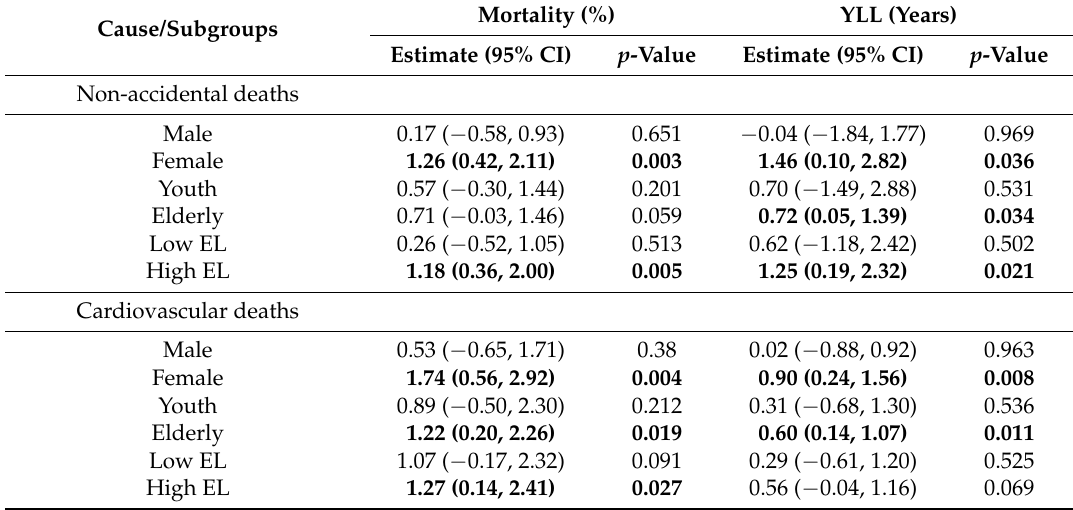
Table 4. Subgroup-specific effects of DTR at lag 0–1 days on mortality and YLL due to non-accidental and cardiovascular deaths in Wuhan, China during